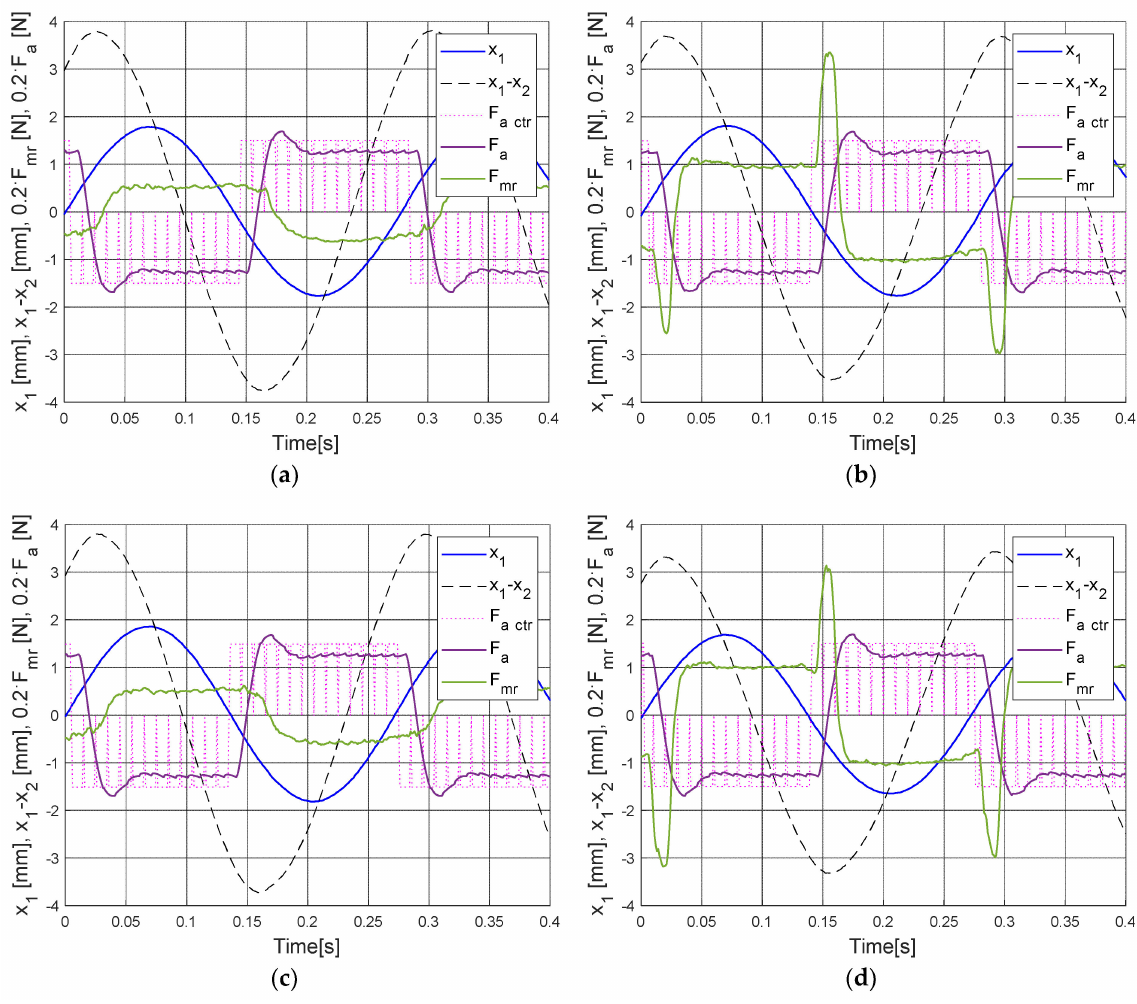
Figure 20. OPT time responses at 3.6 Hz: ( a ) i max = 0, ( b ) i max = 0.5 A vs. OPT time responses at 3.7Hz: ( c ) i max = 0, ( d ) i max = 0.5 A ( F nom = 6.25